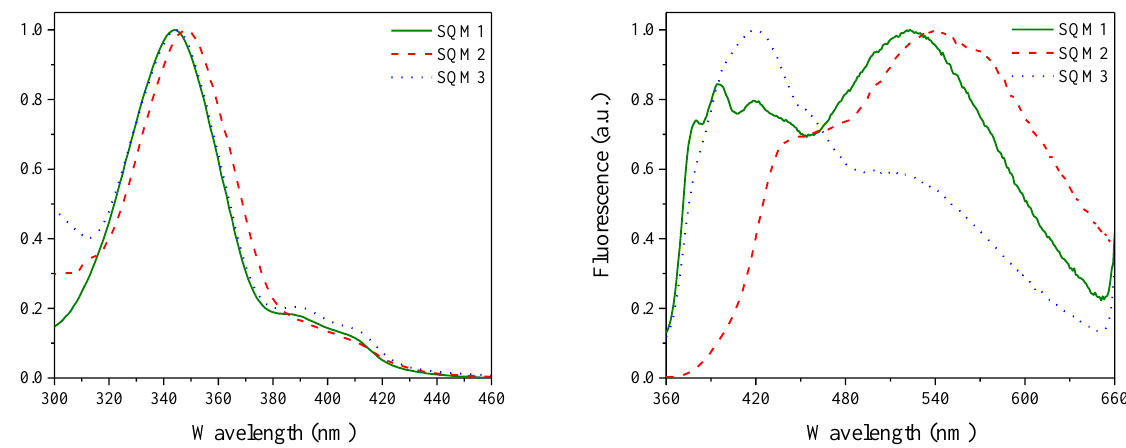
Figure 15. Normalized absorption ( L ) and fluorescence ( R ) spectra of squaraine dyes (SQM1-SQM3) registered in 1-methyl-2-pyrrolidinone (MP) at room temperature. Reproduced from ref. [113], which was published under a CC BY license.